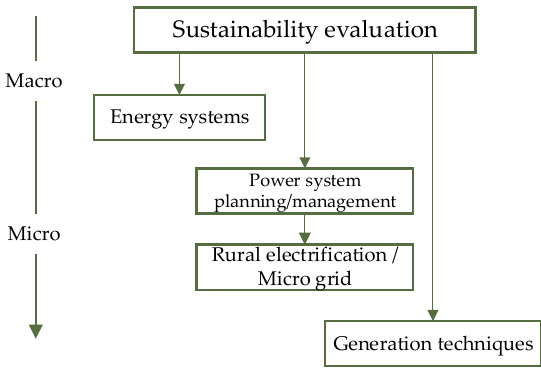
Figure 1. The classification of Sustainability evaluation (SE) on energy related topics. [Reproduced with permission from [6], Chenjun Sun, etc., IEEE Proceedings, IEEE, 2016.]